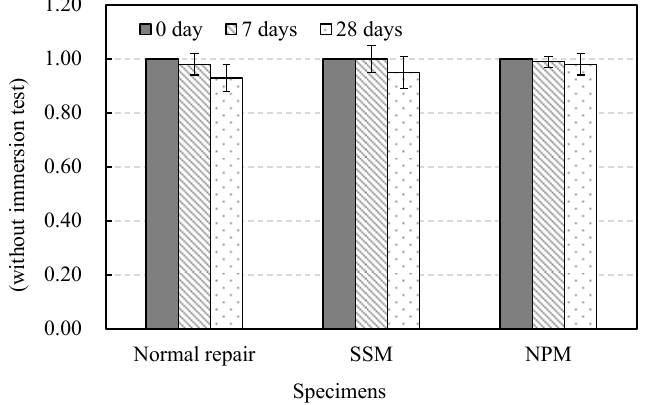
Figure 9. Mass variation of the coated concretes immersed in 5% sulfuric acid solution.